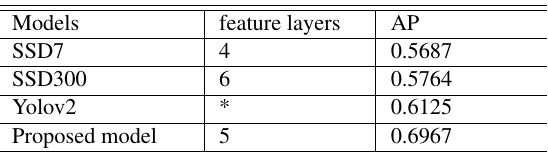
Table 1. Comparison with different approaches on our test